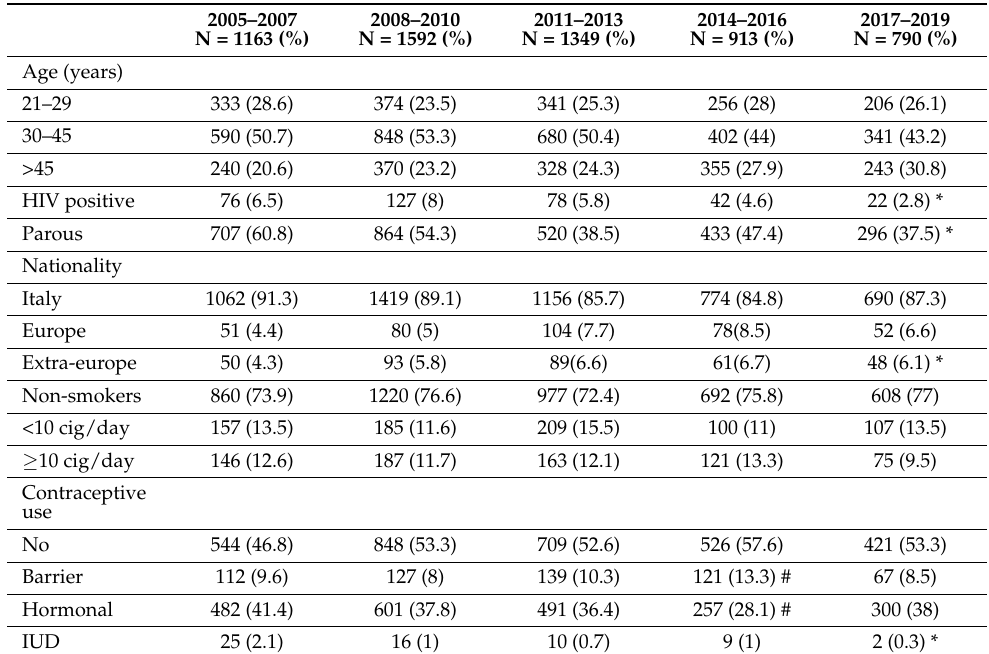
Table 1. Demographical and clinical characteristics of women enrolled in the five periods under